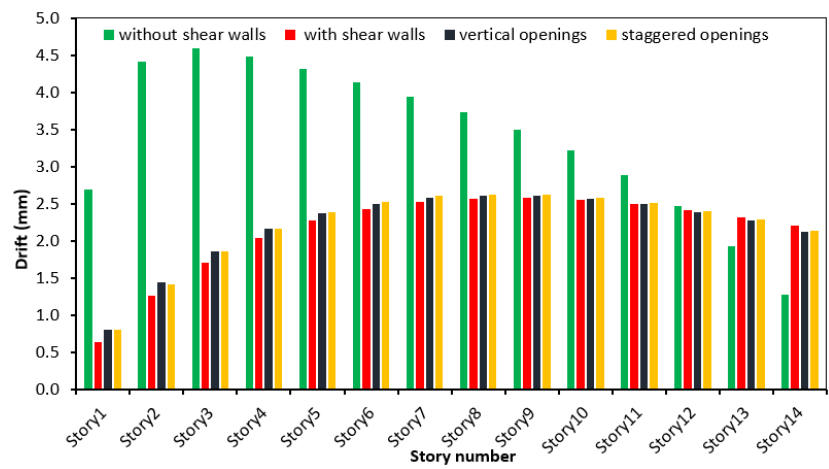
Figure 15. Story drift of the models, response spectrum analysis and X-direction.